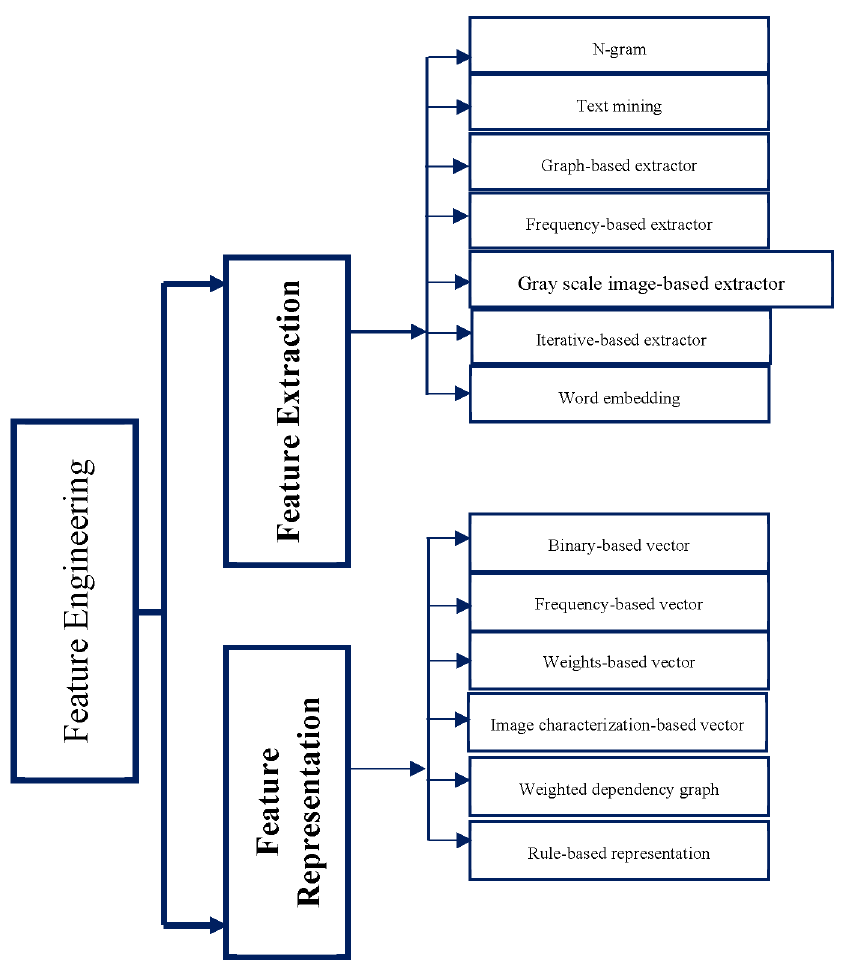
Figure 5 . Taxonomy of feature extraction and representation methods . Figure 5. Taxonomy of feature extraction and representation